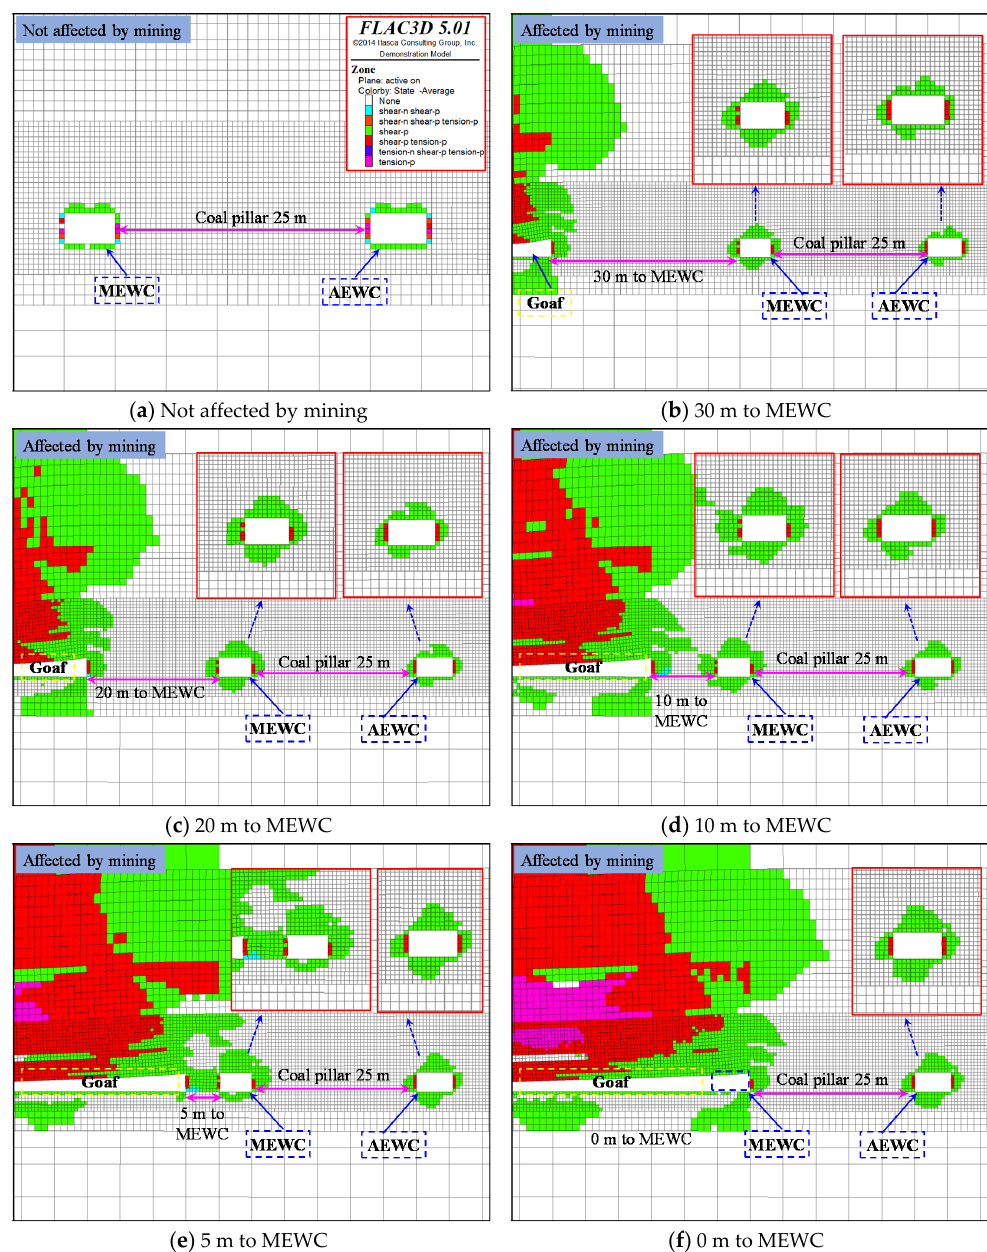
Figure 13. Evolution of the plastic zone.